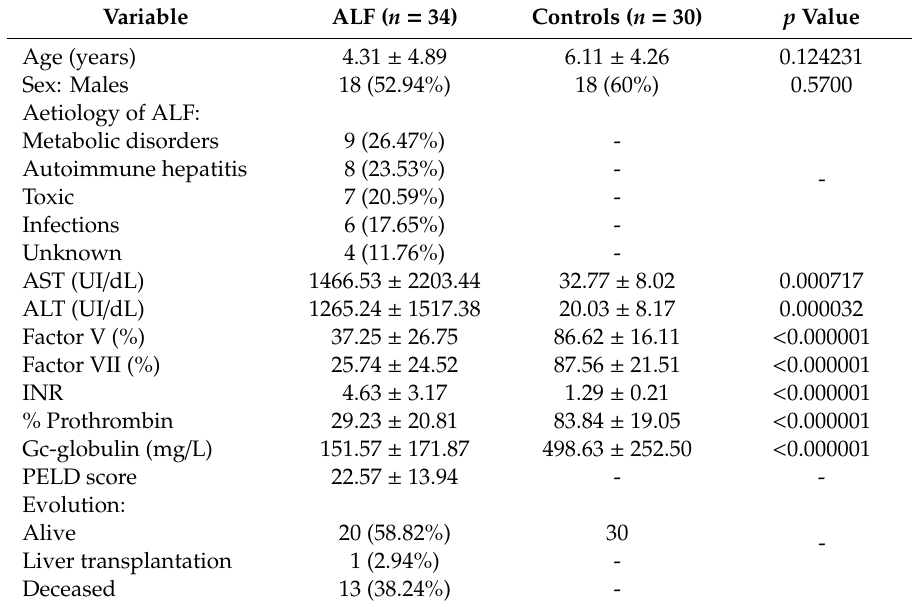
Table 1. Comparison between children with acute liver failure (ALF) and control group